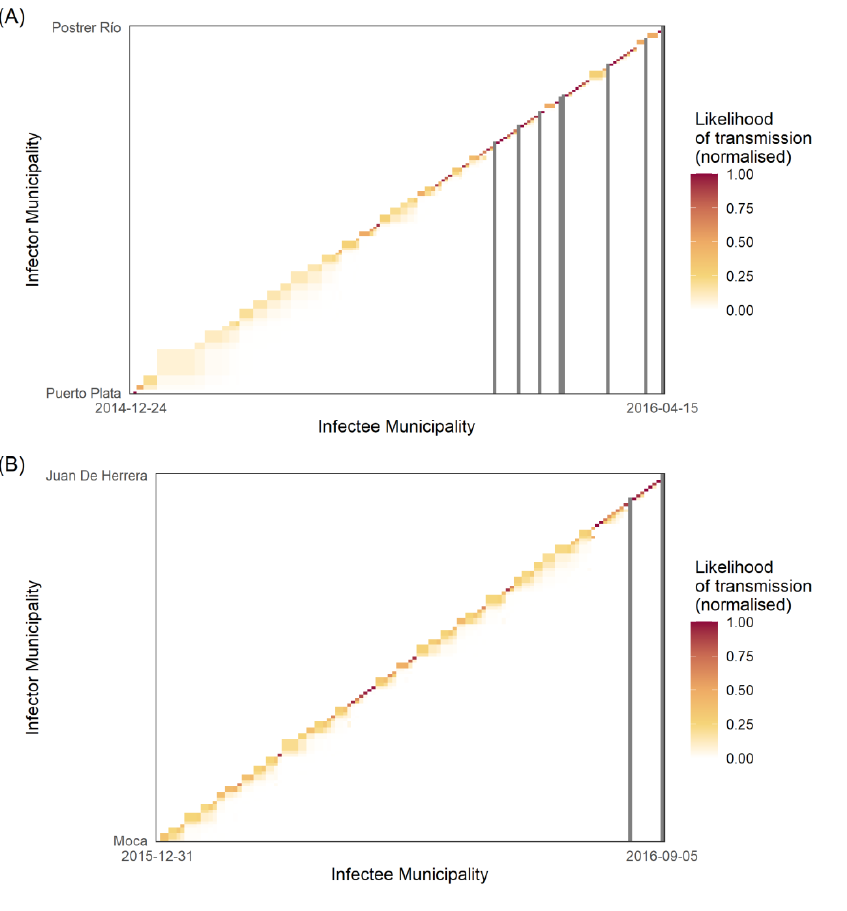
Figure 5. Heatmaps of transmission likelihood of infector–infectee municipal pairs: ( A ) dengue cases; ( B ) Zika cases. The heatmap X axis represents all possible infector municipalities ordered by time of initial symptom onset date; the Y axis represents all possible infectee municipalities ordered by time of symptom onset. Each square represents the transmission likelihood for said infector– infectee pair. Continuous scale from white (0) to red (1) represents the normalised likelihood of transmission, with white squares indicating no likelihood of transmission. Dark grey lines represent where infectee municipalities were unlikely to be infected by other observed municipalities, and so infection occurred by unobserved disease